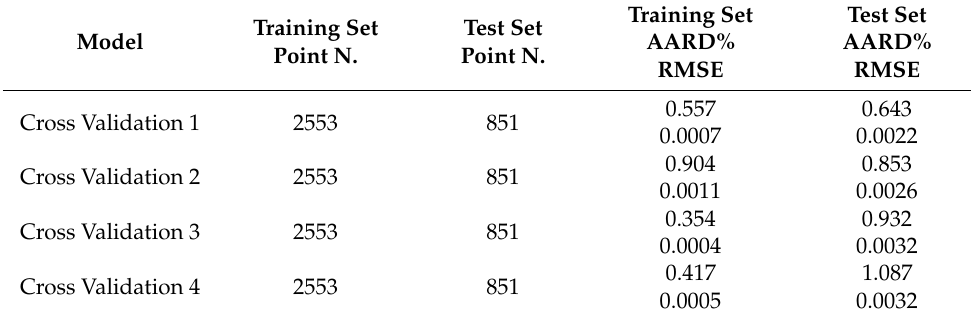
Table 4. Performance of the ANN using a 4-fold cross-validation procedure.